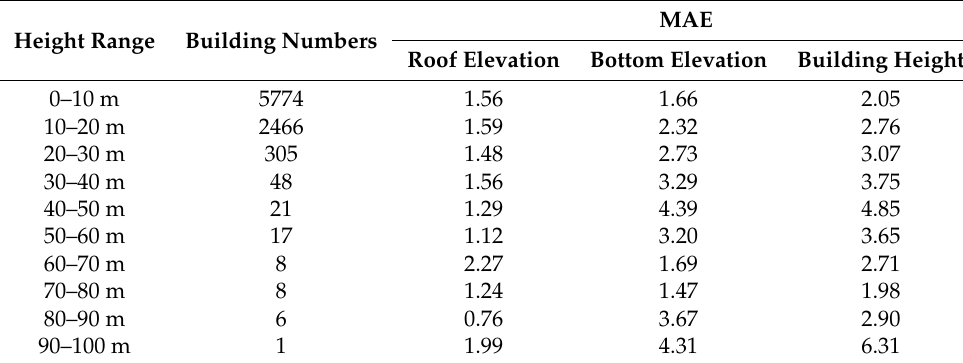
Table 3. Number and accuracy statistic at varying elevation